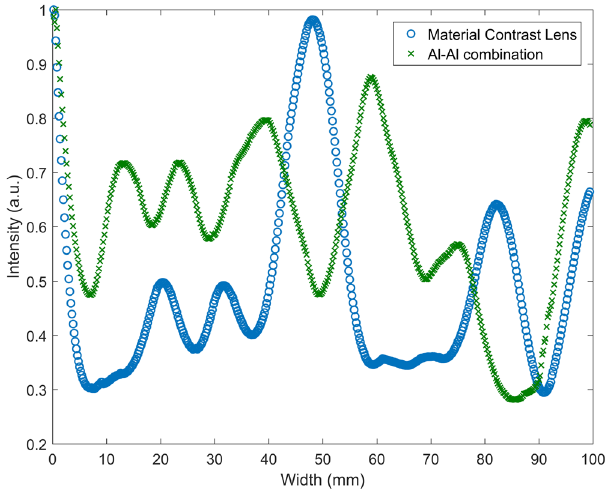
Figure 5. Plot showing the variation of the measured out-of-plane displacement amplitude along the width for material contrast lens compared with Al-Al